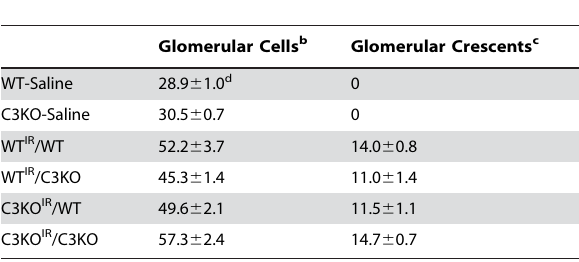
Table 2. Comparison of glomerular cell counts and crescent formation in chimeric mice treated with HSA/LPS versus saline injected controls.